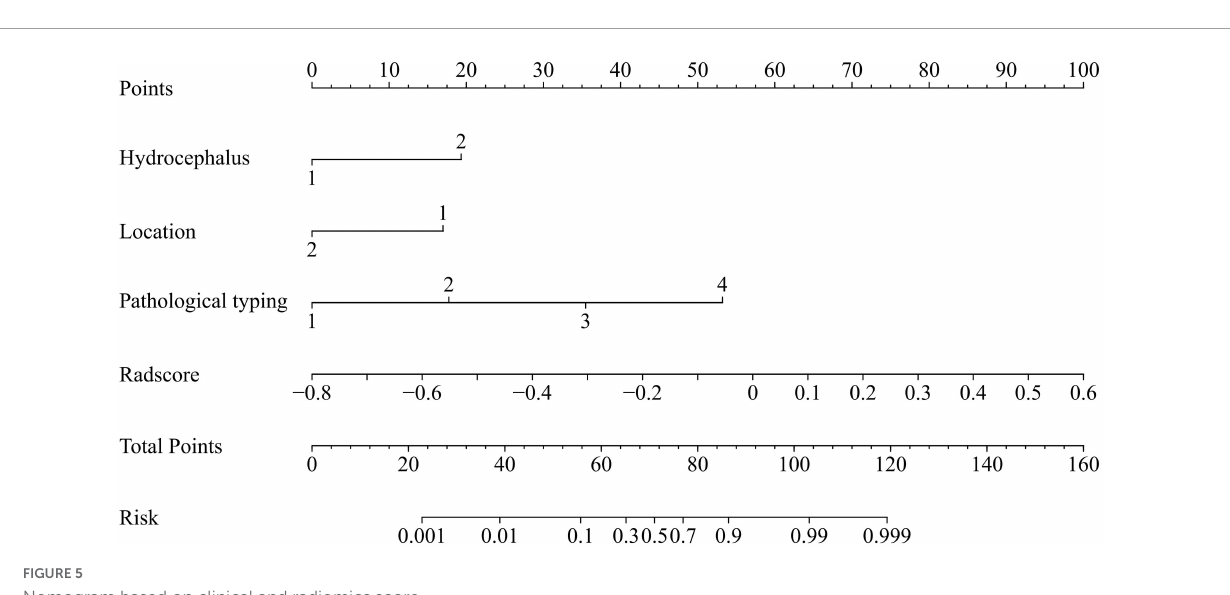
FIGURE5 Nomogram based on clinical and radiomics